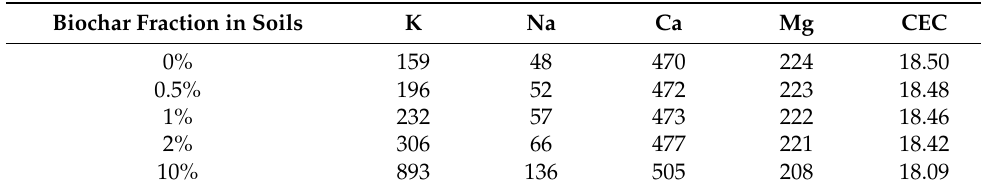
Table 3. Concentration of the exchangeable cations (in mg/kg) and CEC (in cmol/kg) of the biochar/soil mixtures.